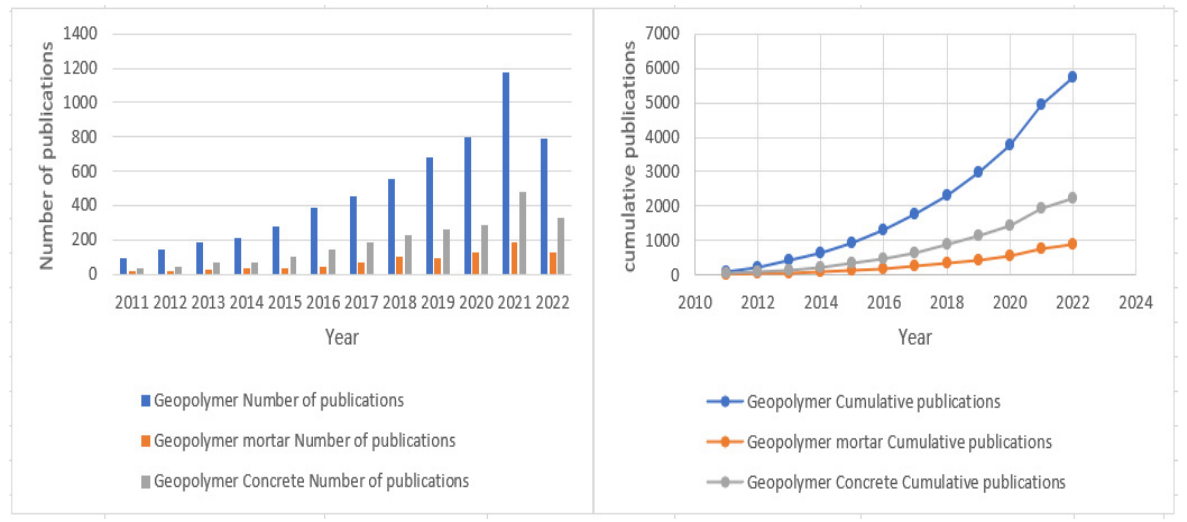
Figure 1. Year-on-year number of publications and cumulative publication trend for the searched keywords as of 25 April 2022.